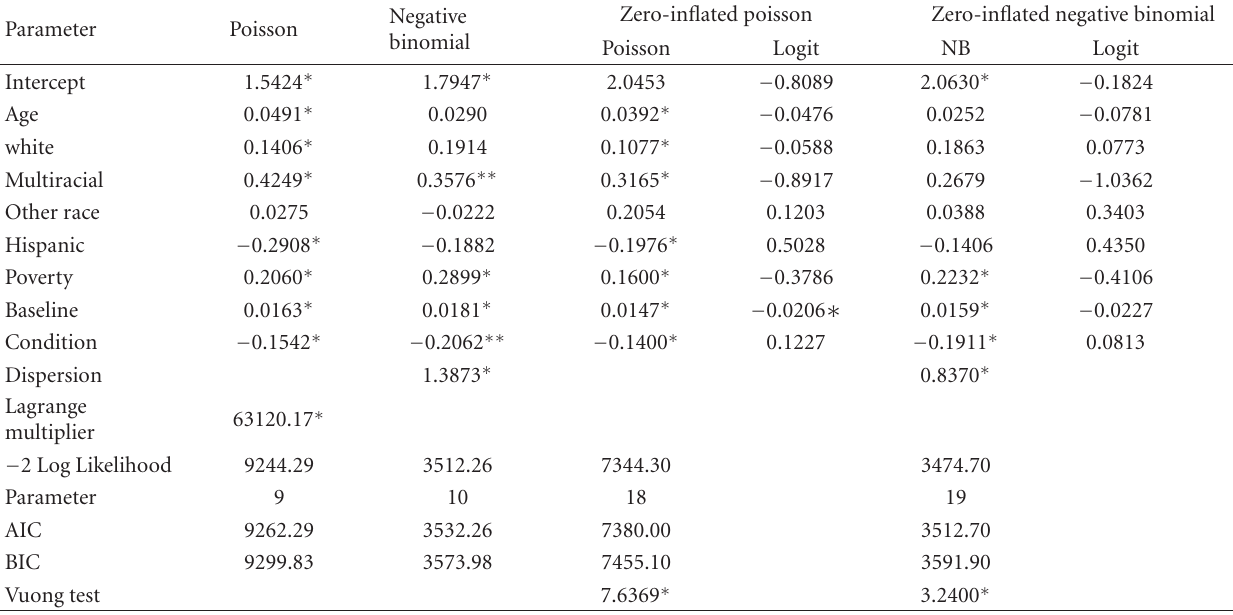
Table 2: The estimated parameters, coe ffi cients of the Poisson, NB, ZIP, and ZINB models for all vaginal sex episodes outcome at 12 months.